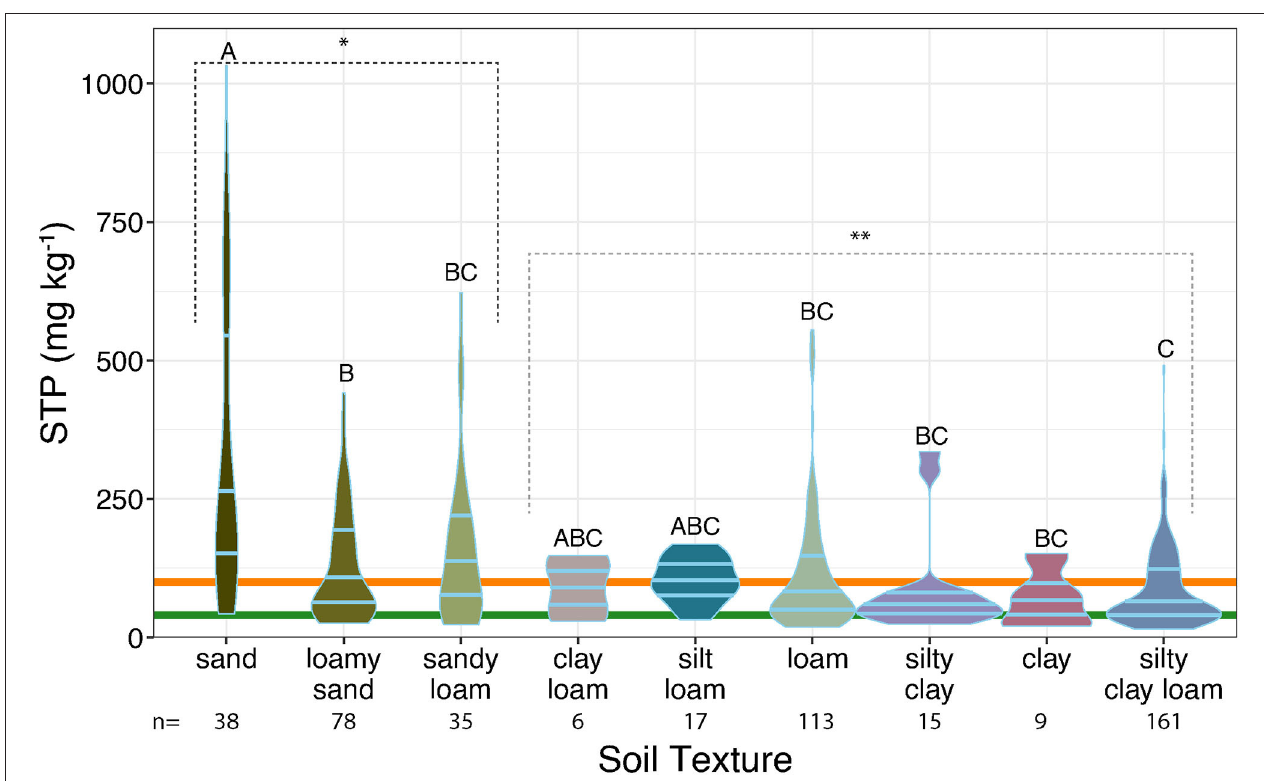
FIGURE 5 | The distribution of STP concentrations by soil texture using violin plots on the selection of 52 elevated-P fields from interested farmers. The light blue lines correspond to the 25-50-75th quantiles. The number (n) of zones for each soil type is shown below the soil types. Groups were compared using the post-hoc Kruskal-Nemenyi test with letters above the violins representing significant differences for individual soil textures ( α < 0.05). This test was also run for sandy against non-sandy soil textures as indicated by asterisks above the gray dashed-lines. Orange and green horizontal lines are placed at the 100 and 40mg P kg − 1 thresholds,